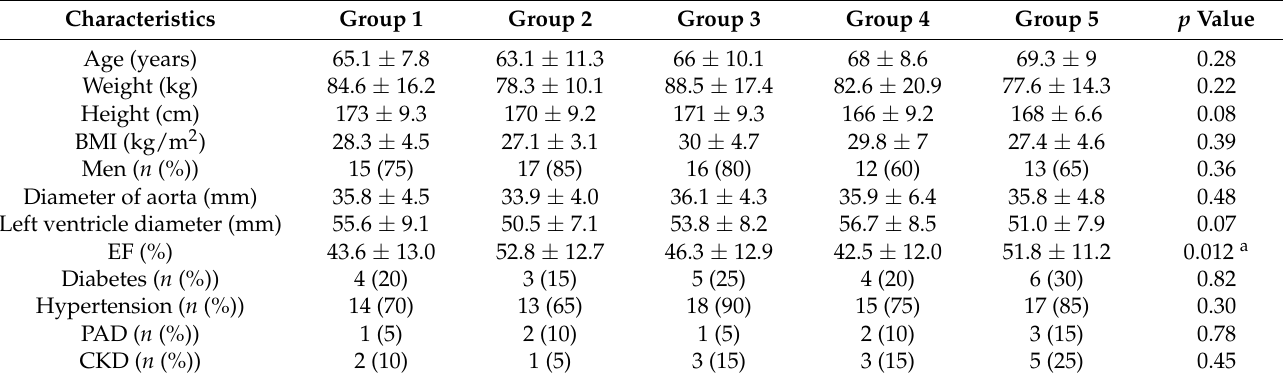
Table 1. Baseline and echocardiographic characteristics.